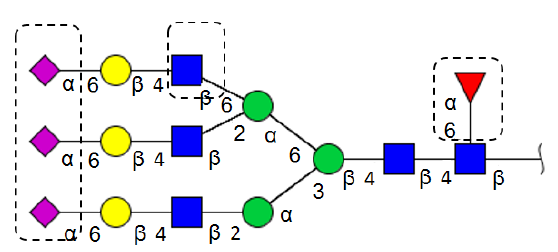
Figure 1: The most common N -glycan alteration observed in tumourigenesis (sialylation, increased β-1,6 branching and core fucosylation). Structure was drawn using a program